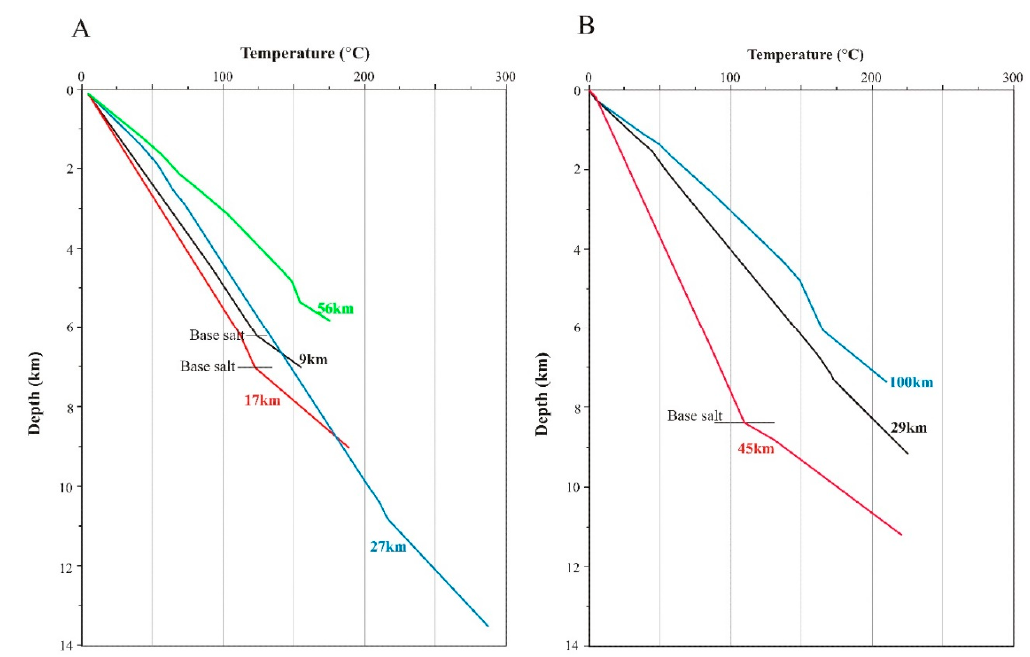
Figure 8. Modeled, present temperature distribution in pseudo-wells along ( A ) section A in the central sub-basin, and ( B ) section B in the eastern sub-basin. Thick lines in the minibasins and platforms wells show the temperature distribution in potential reservoirs. Figure 6 (I) shows the location of the pseudo-wells.